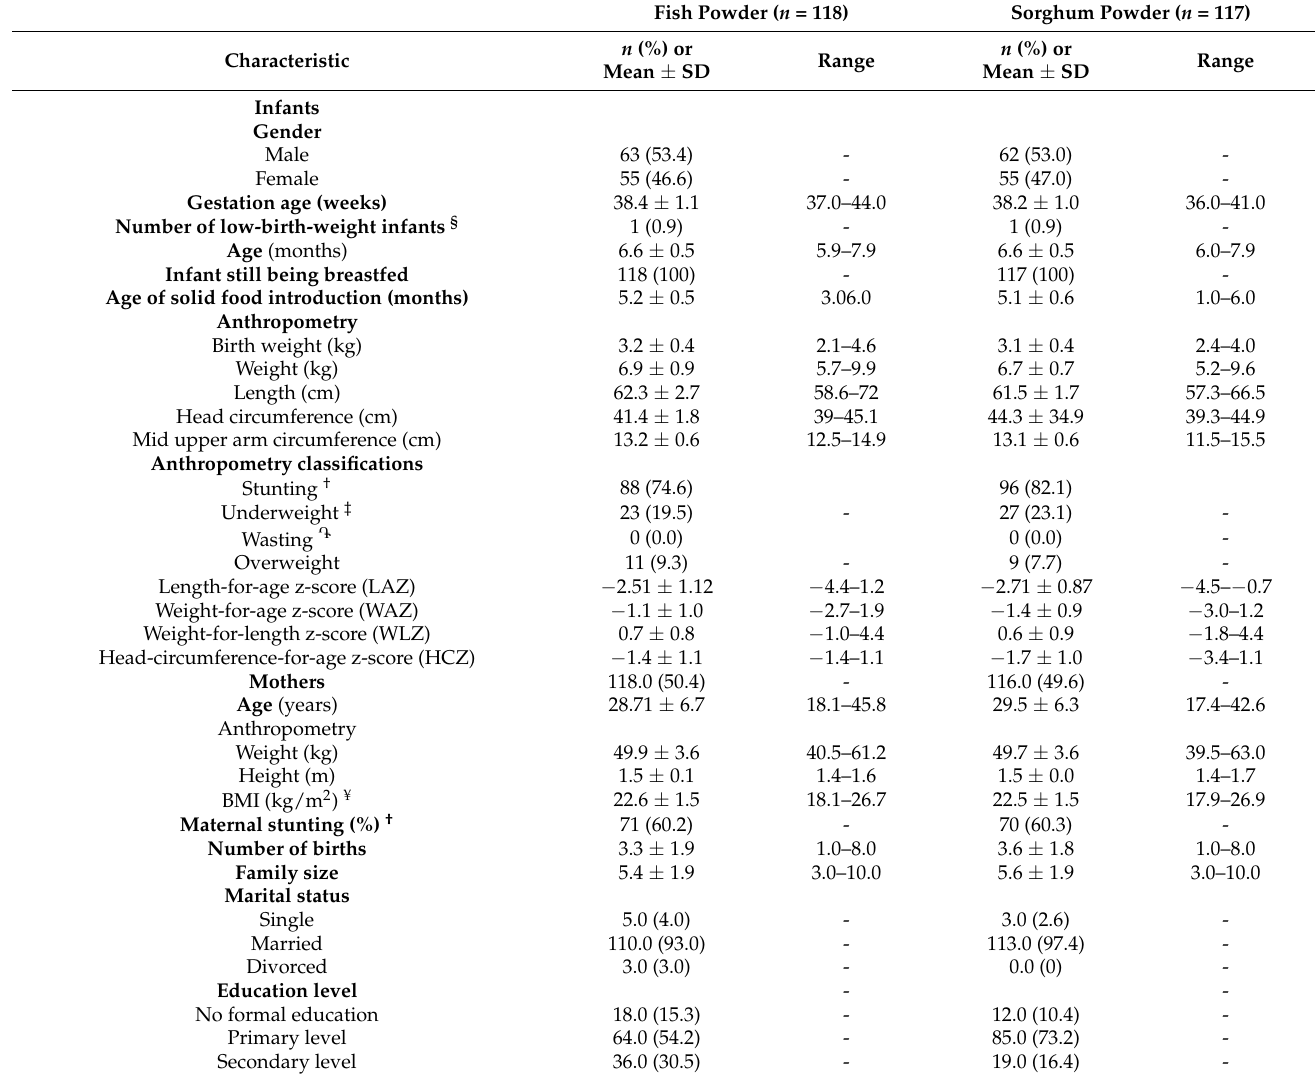
Table 3. Baseline characteristics of participating infants and their mothers by group.